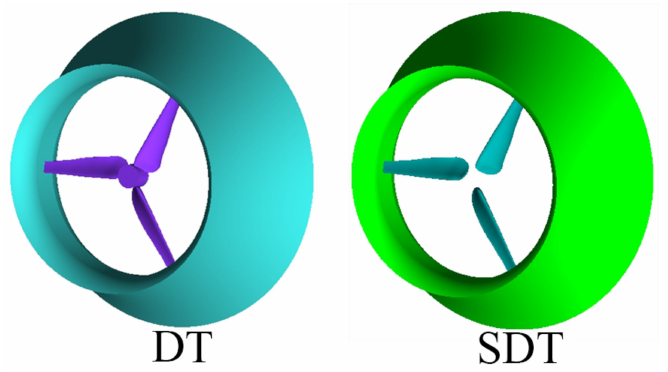
Figure 3. Schematic view of the DT and the SDT.